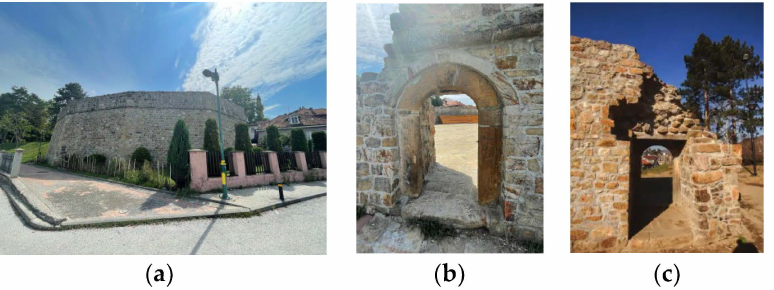
Figure 7. Western Tabia. ( a ) SW-NE view; ( b ) western Tabia entrance portal—view from outside ( c ) western Tabia entrance portal—view from the inside (Photo source: Lejla Ze´cirovi´c).